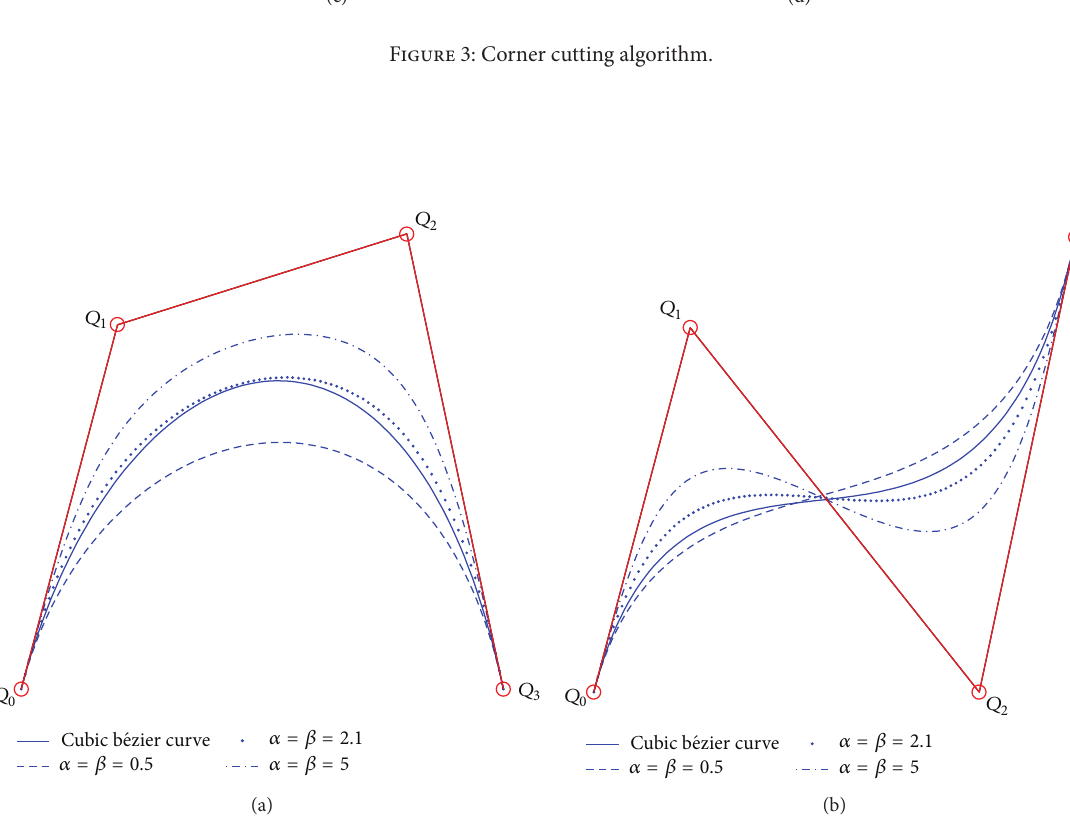
Figure 3: Corner cutting algorithm.